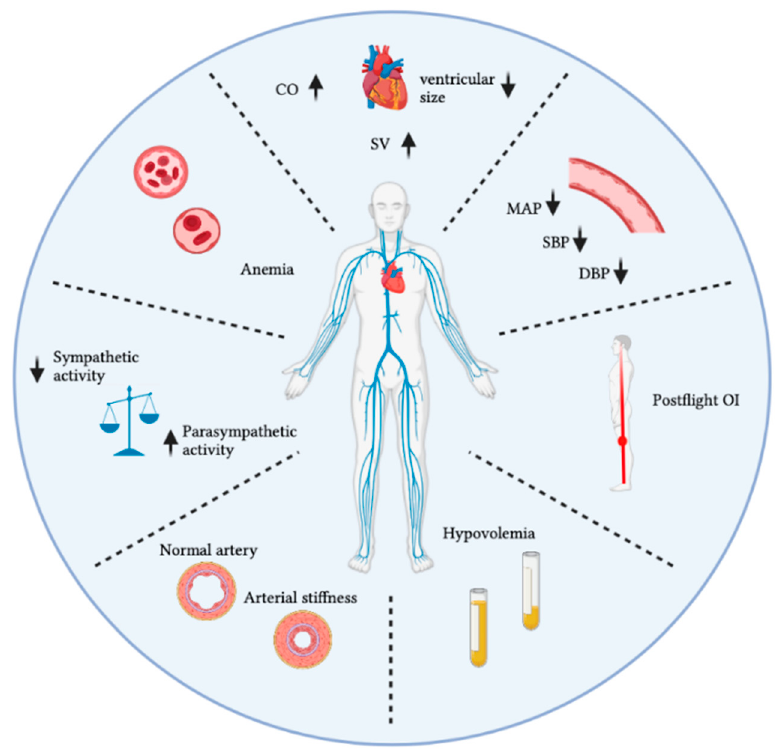
Figure 2. A summary of spaceflight-induced cardiovascular diseases. Abbreviations: cardiac output (CO); stroke volume (SV); mean arterial pressure (MAP); systolic blood pressure (SBP); diastolic blood pressure (DBP); orthostatic intolerance (OI); increase (↑ ); decrease ( ↓ ).